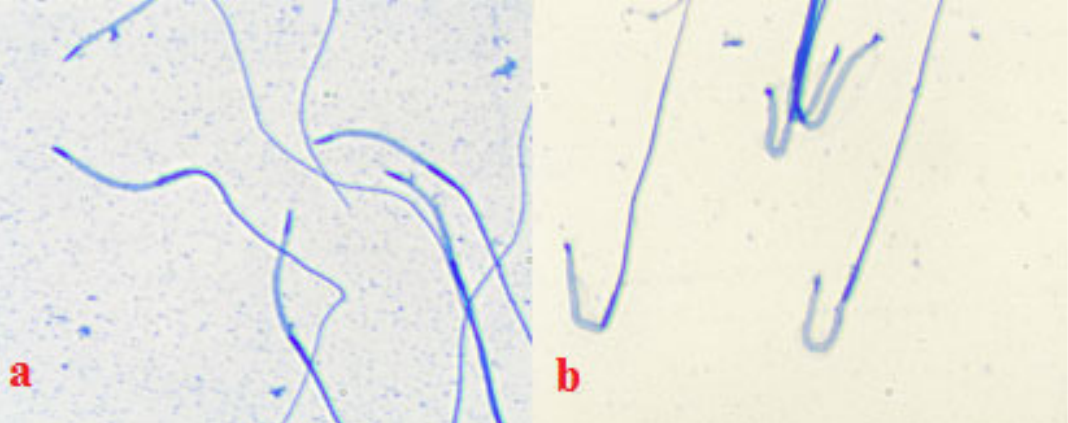
Figure 3. Damage to spermatozoa under the influence of technological factors: changes in intactness of the acrosomes of spermatozoa (Coomassie) in the LCM control: ( a ) storage for 3 h ( b ) thawed spermatozoa. Of all the technological stages, the greatest damage to spermatozoa acrosomes was noted at the stage of